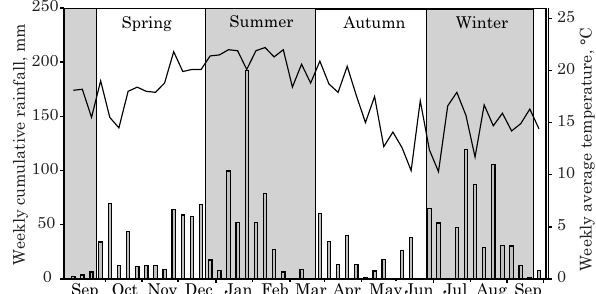
Figure 2. Weekly cumulative rainfall (bars) and average weekly temperature (lines) at the study site between September 2010 and September